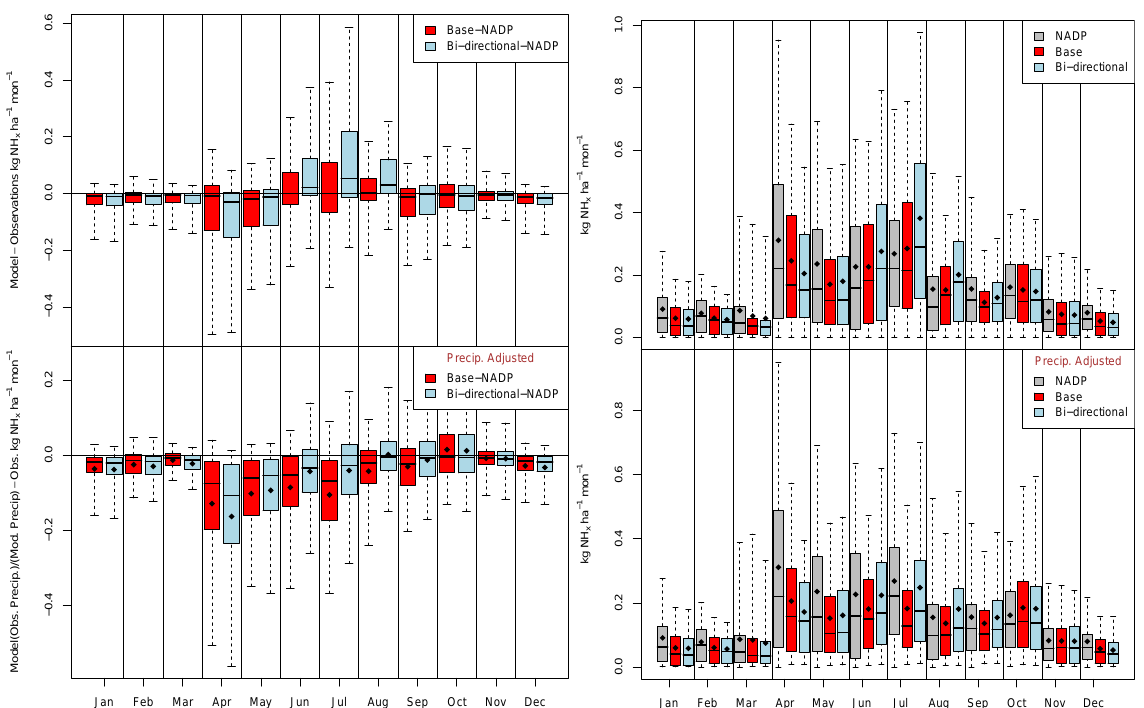
Fig. 3. Box plots of NH x wet deposition monthly model bias (top two panels) and total simulated wet deposition (bottom two panels) paired in space and time with NADP observations ( N = 560 to 863 per month) for the CMAQ base case estimates (red) and CMAQ with bidirectional case (blue). Monthly biases and total deposition for the raw model output are presented in the top panel of each set and precipitation corrected biases are presented in the bottom panel of each set. The boxes enclose the 25th to 75th percentiles, the whiskers represent the 5th and 95th percentiles, the horizontal bar represents the median, and the black diamond represents the mean.